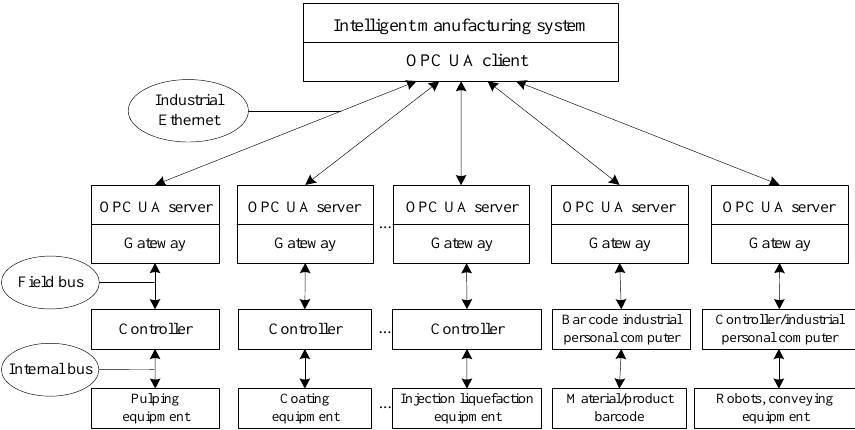
Figure 9. Architecture of OPC UA server / client in lithium ion battery intelligent manufacturing